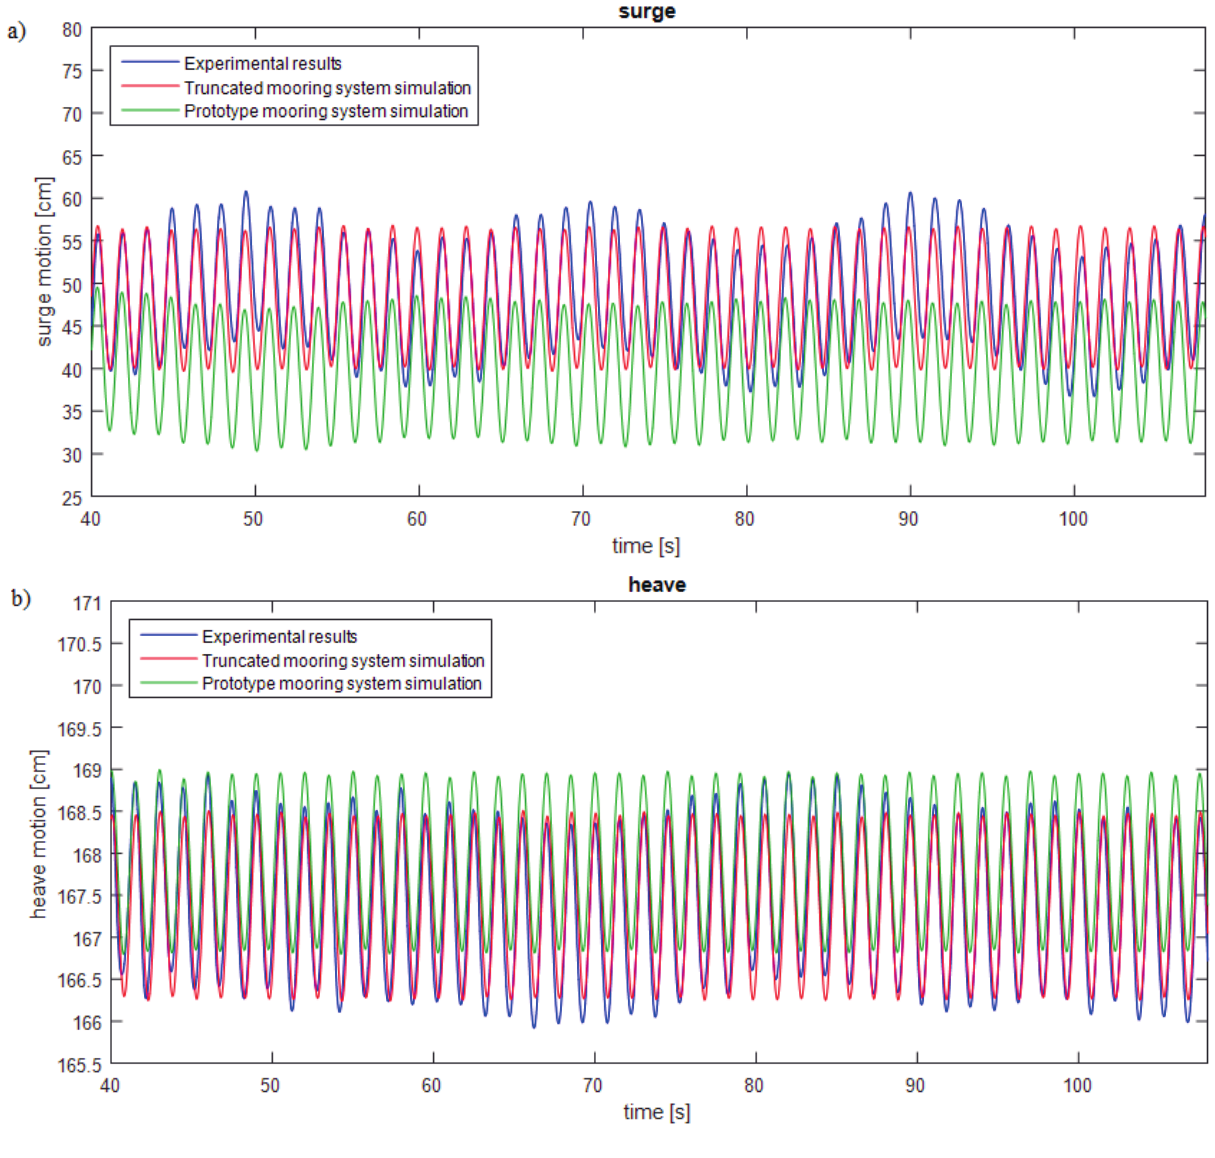
Figure 14. Comparison surge ( a ) and heave ( b ) nacelle motion